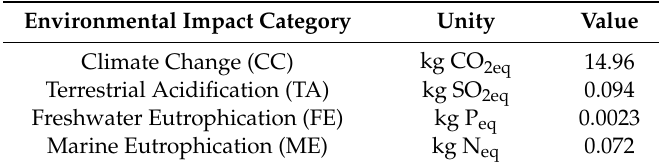
Table 4. Final results of the impact assessment associated with the production of 1 kg of